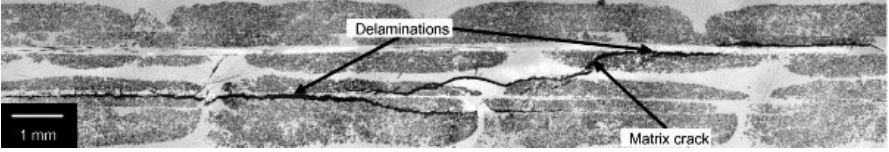
Figure 3. Composite material with defects caused by mechanical impact [12,13,19].